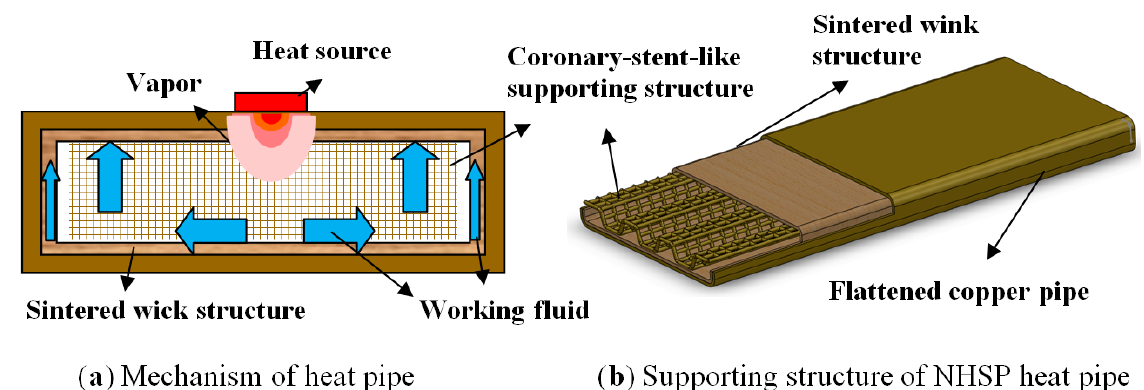
Figure 1. Working mechanism and supporting structure of the NHST heat